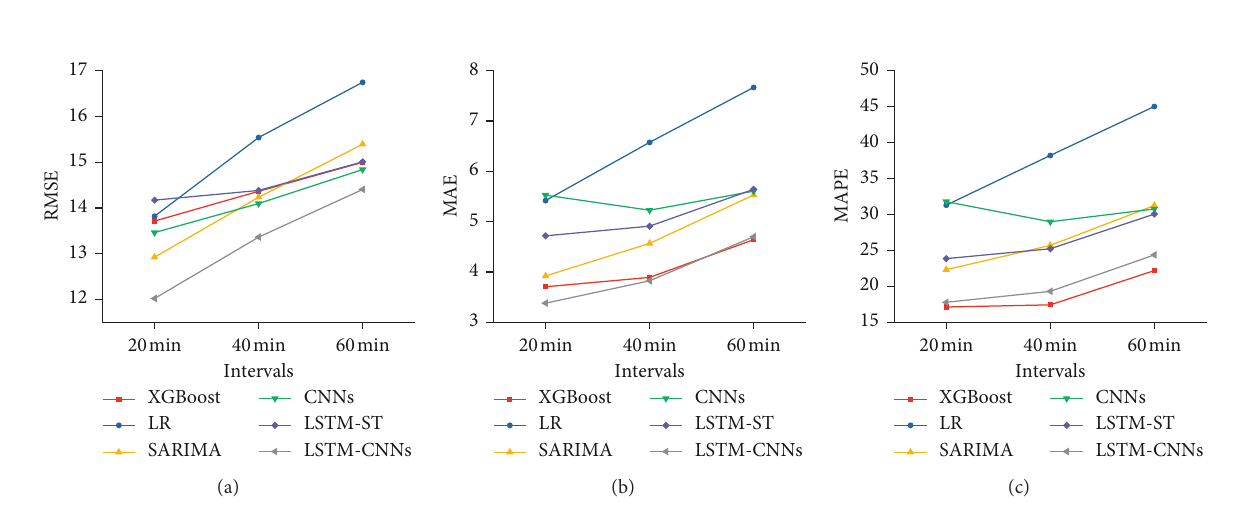
Figure 15: Long-term prediction error results. Table 9: Long-term prediction error results of different